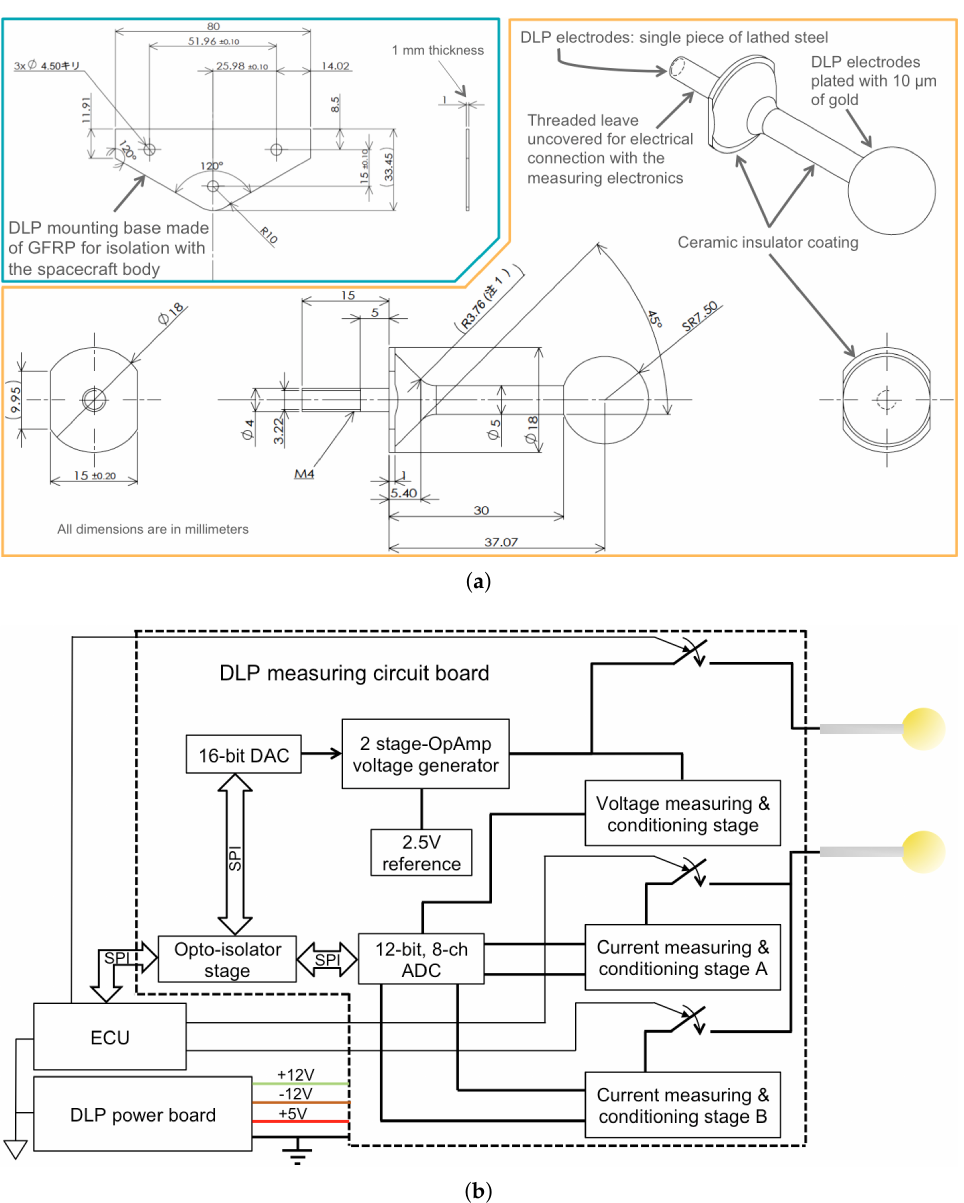
Figure 5. Representation of the DLP measuring system: ( a ) DLP electrode made of solid aluminum, coated with 10 µ m of gold in the spherical tip, ceramic material (in white color) in the shaft for isolation and FR4 plate (in gray) on the base for isolation purposes from the structure of the spacecraft; and ( b ) the DLP measuring circuit block diagram. The dashed line indicates the DLP measuring circuit physically implemented in a single